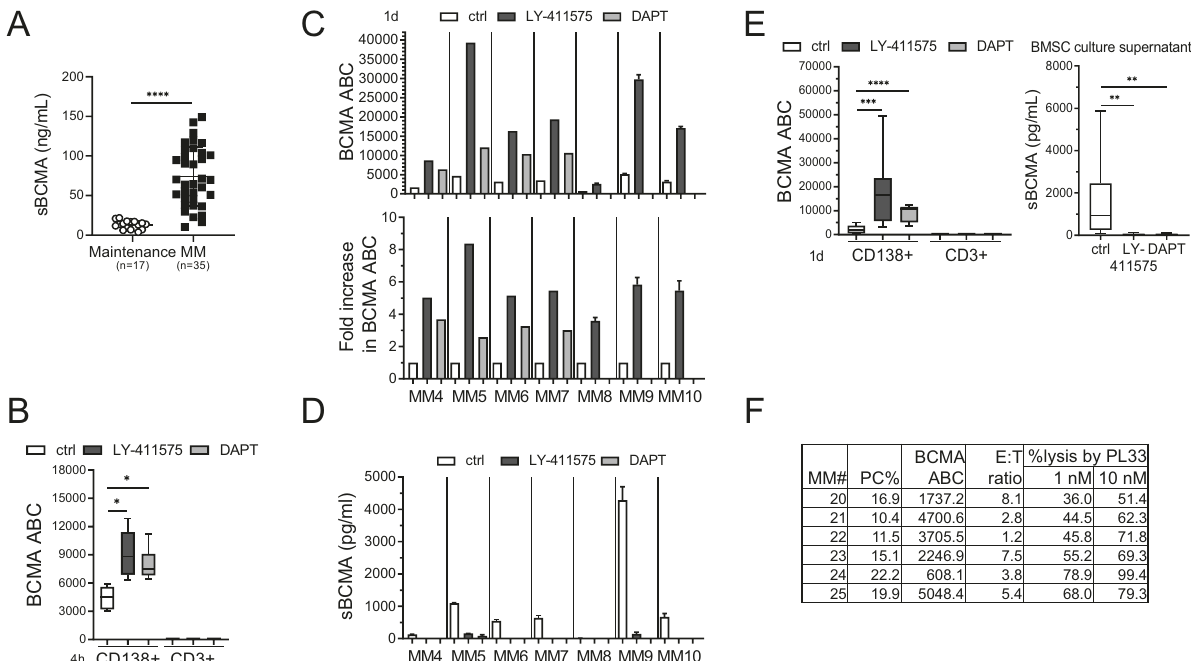
Fig. 3 GSIs robustly upregulated mBCMA densities on patient MM but not T cells, signi fi cantly associated with sBCMA elimination in supernatants of 1 day-patient cell cultures. A Serum sBCMA (ng/mL) levels were determined in patients with active MM diseases ( n = 35) and at maintenance after treatment response ( n = 17). B – E BMMCs (10 5 cells per well in 96-well culture plates) from MM patients were treated with LY-411575 (2 nM) or DAPT (1 µM) for 4 h ( B , n = 3) or 1 day ( C , D n = 7, E , n = 9) followed by quantitative FC analysis ( B , C ; E , left panel) and ELISA ( D , E , right panel) to determine BCMA ABC on CD138 + ( B , C ; E , left panel) vs. CD138 − CD3 + T-cell subsets ( B ; E , left panel) and sBCMA concentrations in 1 day-culture supernatants ( D ; E , right panel), respectively. F PL33 of 1 and 10 nM was added in BMMCs collected from more MM patients for 1 day followed by quantitative FC analysis to determine % autologous CD138 + cell lysis. Shown are also % PC (plasma cell, CD138 + ), BCMA ABC, and CD3 + T cells in these samples (MM20-25, n = 6). Multiple experiments were done in triplicate at each treatment using multiple patient materials. Data are presented as means ± SDs (error bars). * P < 0.05; ** P < 0.01; *** P < 0.001; **** P < LY-411575 co-treatment minimally affected T-cell checkpoint markers and T-cell differentiation in the MM-PBMC/T co- cultures In 1 day-co-cultures of MM1S-PBMCs ( n = 3, E: T = 5:1), PL33, but not ER79, enhanced expression of checkpoint markers (PD1, TIGIT, LAG3) in T cells, which was slightly decreased in the presence of LY-411575 (Supplementary Fig. S3). Also, PL33 induced % effector memory (EM, CD45RA − CD62L − ) and/or terminal effector memory RA (TEMRA, CD45RA + CD62L − ) from naïve (CD45RA + CD62L + ) subsets in these activated T cells of normal donor and patient PBMCs. LY-411575 further enhanced % EM and/or TEMRA T-cell